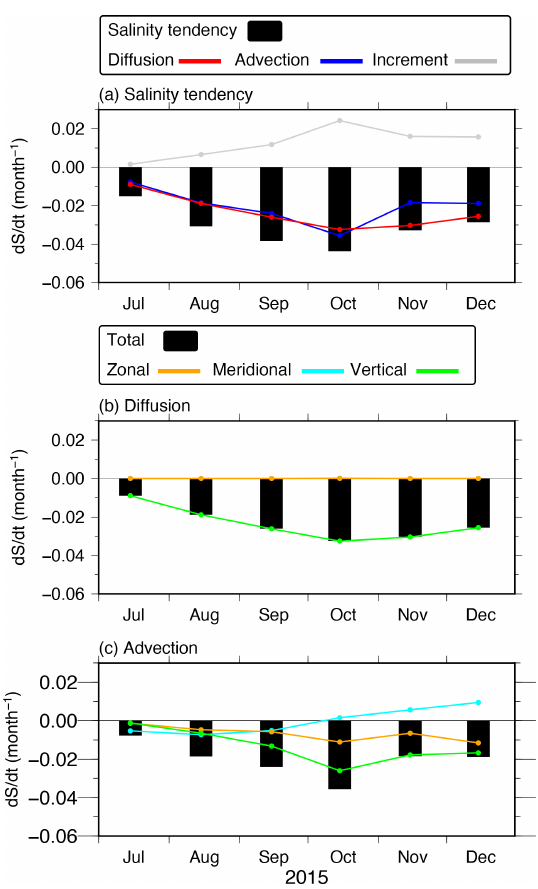
Figure B1. (a) Monthly mean for each term for the difference between the AOEI and CTL runs in the salinity budget equation (Eq. B1): the salinity tendency difference term (the LHS term; black bars), the salinity diffusion difference term (the first term on the RHS; red line), the salinity advection difference term (the second term on the RHS; blue line), and the salinity analysis increment dif- ference term (the last term on the RHS; gray line). Panels (b) and (c) are the same as (a) but for the salinity diffusion and advection difference terms (black bars), respectively, as well as the zonal (or- ange lines), meridional (cyan lines), and vertical (green lines) com-